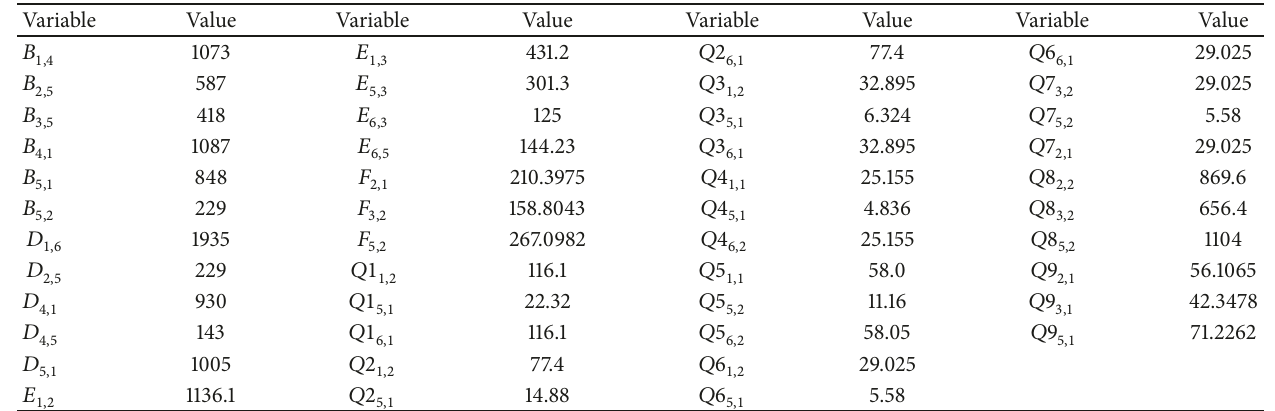
Table 12: Numerical solution in the case that 𝛿 = 0.1 and 𝜆 = 0.5 .